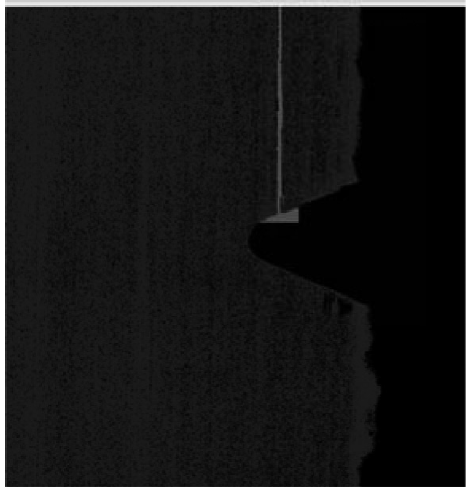
Fig. 14. Specimen side view highlighting the capabilities of the region growing algorithm to isolate the crck area.